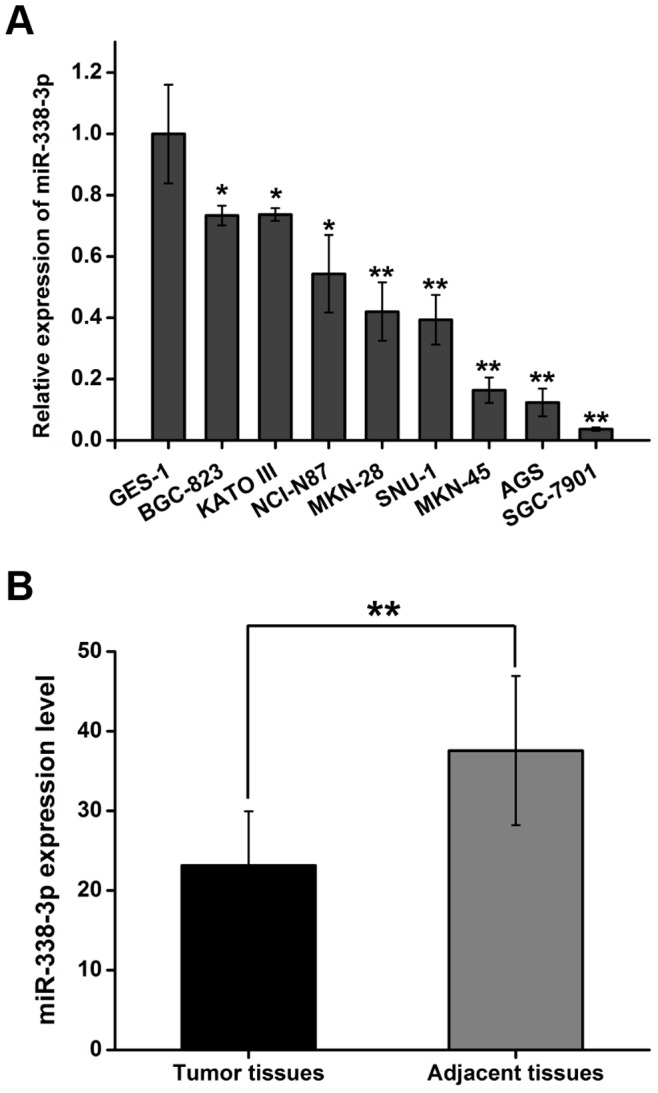
Downregulation of miR-338-3p expression in gastric cancer cell lines and GC tissues compared with the corresponding controls.(A) Relative expression of miR-338-3p in gastric cell lines and the immortalized normal gastric mucosal epithelial cell line (GES-1) (*P<0.05, **P<0.01) were detected by qPCR. (B) qPCR for expression of miR-338-3p was carried out using 66 cases gastric cancer tissues and matched adjacent tissues. The mean and standard deviation were shown (**P<0.01).